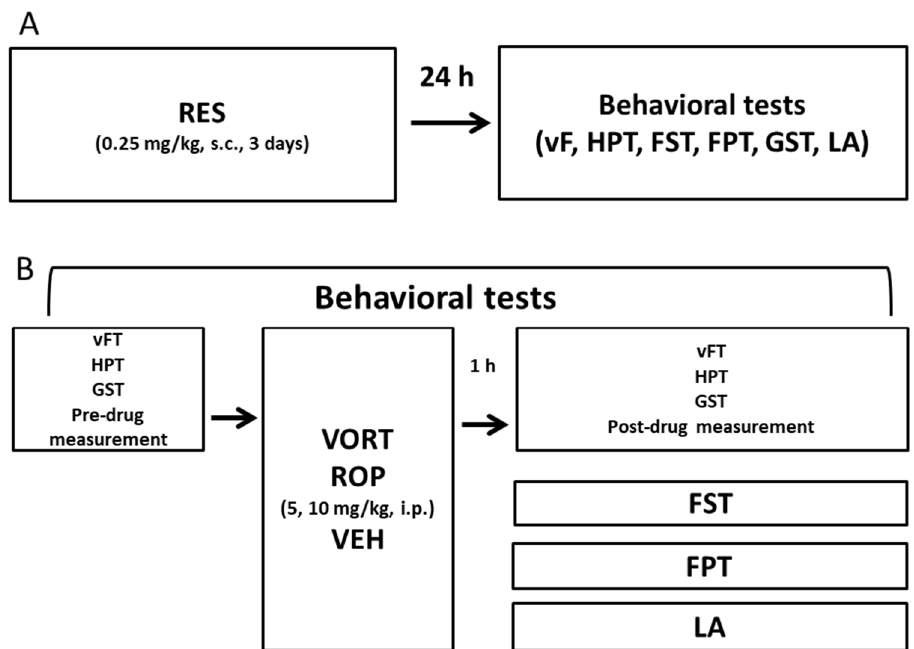
Figure 1. Experimental design used in the present study. FM-like model was induced in mice by a 3-day administration of subcutaneous reserpine (RES; 0.25 mg/kg). Twenty-four hours after the last administration of RES, behavioral tests were carried out ( A ). Vortioxetine (VORT) and ropinirole (ROP) were injected intraperitoneally at doses 5 and 10 mg/kg ( B ). Before test compound administration and 1 h later, the effects of test drugs on tactile allodynia and heat hyperalgesia were measured in the von Frey test (vFT) and the hot plate test (HPT), respectively. Antidepressant-like and anxiolytic-like activities of VORT and ROP were measured in the forced swim test (FST) and the four-plate test (FPT), respectively. Effects of test drugs on the muscle strength were measured using the grip strength test (GST), while the effects of VORT and ROP on the locomotor activity of mice were measured using the locomotor activity test (LA).